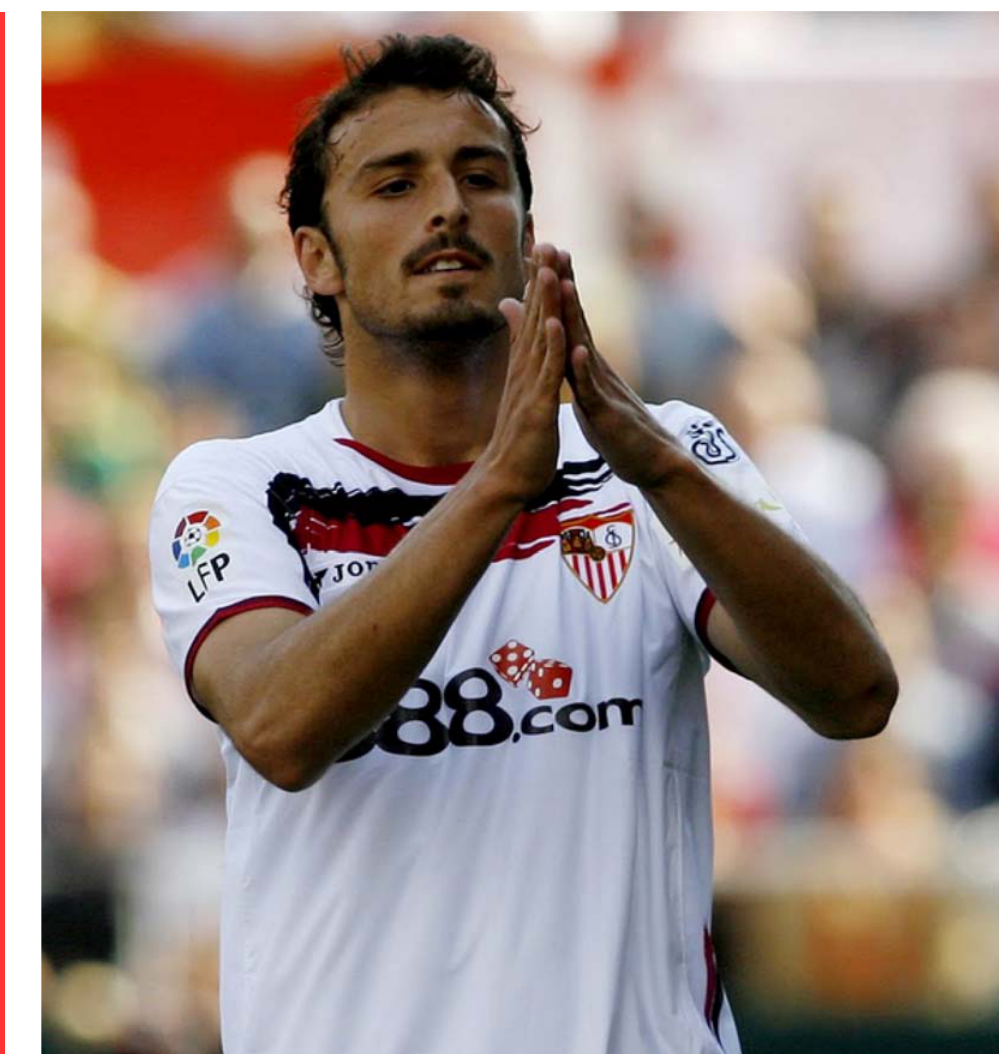
Figure 5. Antonio Jose Puerta Perez (1984–2007), a Spanish midfielder who used to play for FC Sevilla was affected with ARVC, 3 days after suffering a series of cardiac arrests during a Spanish league game against